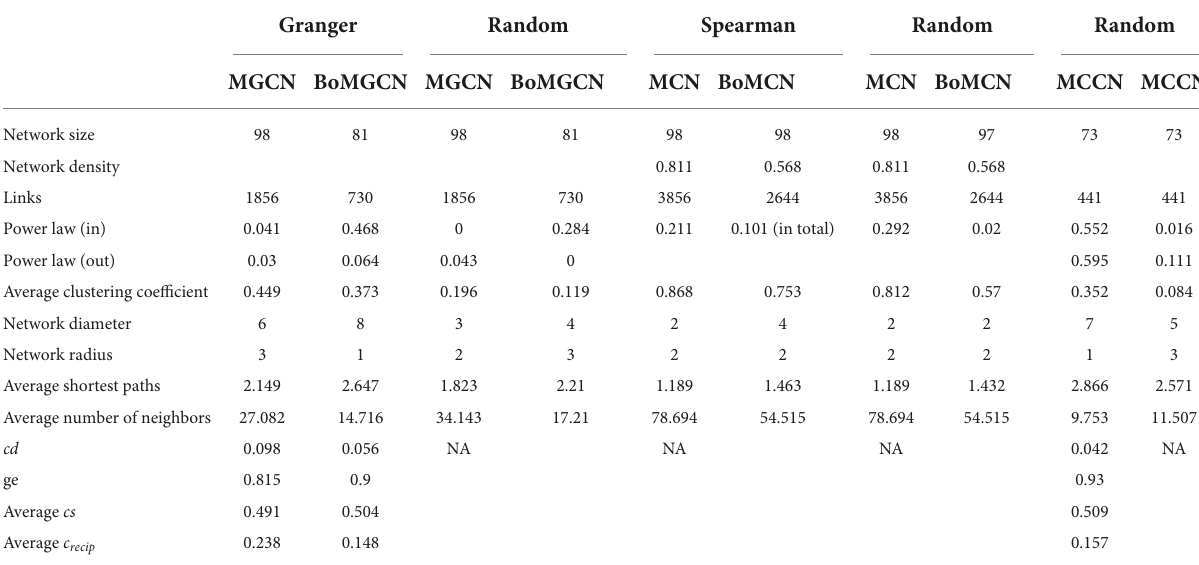
TABLE 1 Properties of different